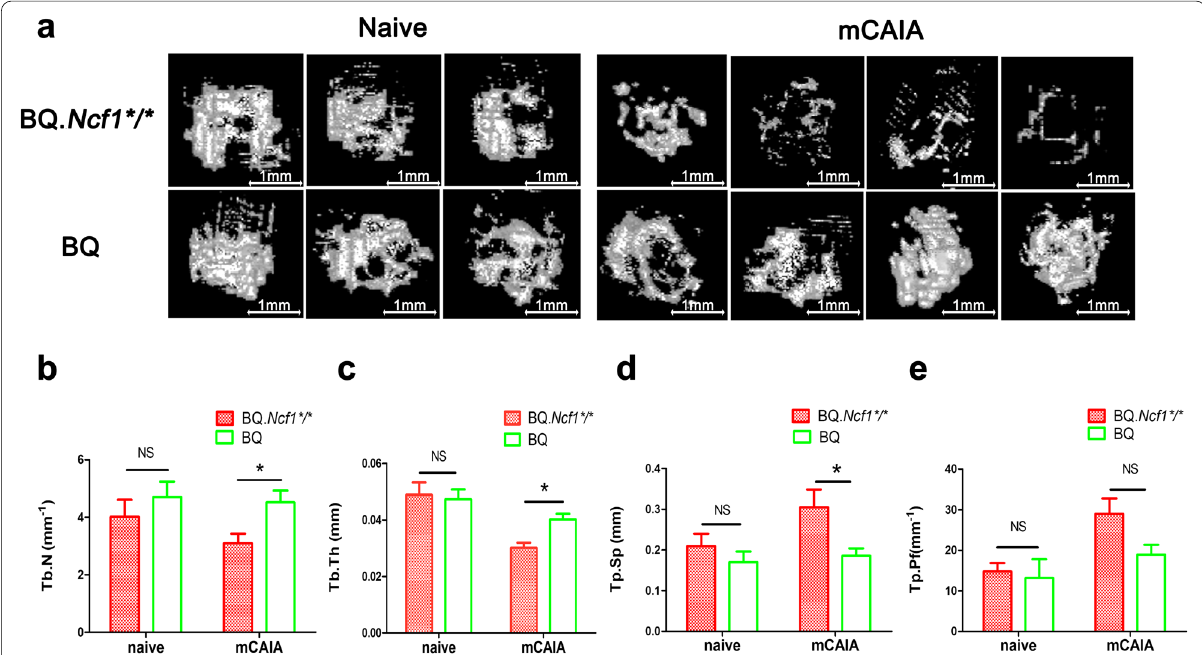
Fig. 3 Distal tibial fractures damaged in the chronic phase of mCAIA in BQ. Ncf1 */* mice. Micro-CT of BQ. Ncf1 */* and BQ mCAIA (14–16 weeks old, n 4) and naïve ( n 3) mice distal tibial fractures on day 200. a Micro-CT images of distal tibial fractures. b Trabecular number (Tb.N), ( c ) Trabecular = = thickness (Tb.Th), ( d ) Trabecular spacing (Tb.Sp), and ( e ) Trabecular pattern factor (Tb.Pf). The data shown are